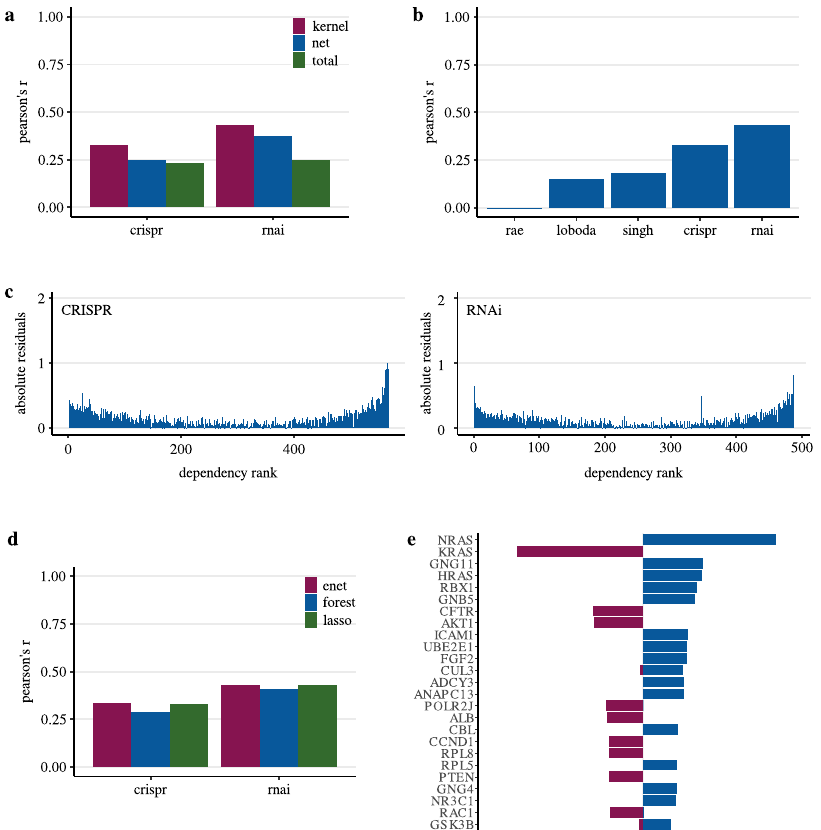
Fig. 4 Performance of different KRAS dependency modeling strategies and predictor analysis in KRAS wt cell lines. a Correlation analysis (Pearson ’ s r) in independent test sets between the experimentally determined KRAS cancer cell line dependency and our machine learning- based predictions for varying sets of predictors (see methods). Results are shown for models using all available predictors of the RNA sequencing data (total), all available predictors of the protein interaction network (net) and predictors selected by the diffusion kernel with hyperparameter optimization (kernel). Models were based on KRAS wt cell lines of the different datasets (crispr - Achilles CRISPR effect data ( n = 567), rnai - DRIVE RNAi (DEMETER2) data ( n = 487)). In case of the diffusion kernel variable selection work fl ow maximum correlation was reached with a hyperparameter constellation using 500 predictors. For complete results of hyperparameter tuning see Supplementary Data 4. b Performance (Pearson ’ s r) of KRAS dependency models in KRAS wt group compared between the different approaches (RAE – RAE-based models (CRISPR data), Loboda – Models using RNA expression of the gene selection by Loboda et al. (CRISPR data), Singh – Models using RNA expression of the gene selection genes by Singh et al. (CRISPR data), CRISPR – Best performing models using RNA expression of the gene selection by the diffusion kernel with optimized hyperparameters (CRISPR data), RNAi – Best performing models using RNA expression of the gene selection by the diffusion kernel with optimized hyperparameters (RNAi data)). For CRISPR/RNAi correlation analysis was performed similarly to ( a ). Correlation coef fi cients for RAE, Loboda and Singh were determined as described above. c Absolute error of CRISPR/RNAi models for each cell line using mutation- and best performing RNA-predictor set. Summarized results of 400 unique models are shown in the two waterfall plots. Cell lines were ordered by ascending observed KRAS dependency from left to right. The absolute error was estimated by summing the individual absolute differences of the predicted values from the observed values. d Correlation analysis (Pearson ’ s r, n CRISPR = 567, n RNAi = 487) performed similarly to ( a ) this time comparing models using different algorithms (Elastic Net regression - enet, Random Forest regression – forest, Lasso regression - lasso). Neither Elastic net nor Random Forest Regression could improve the Lasso predictions of KRAS dependency. e Occurrence frequency of RNA-predictors in 12000 unique models of KRAS dependency (CRISPR/RNAi) in KRAS wt cancer cell lines. Only models using the variable selection by the diffusion kernel were included. Negative values indicate the frequency of how often the predictor had a negative coef fi cient in the models (associated with higher KRAS dependency), positive values the frequency of how often the predictor had a positive coef fi cient (associated with lower KRAS dependency). The 25 most redundant genes are shown